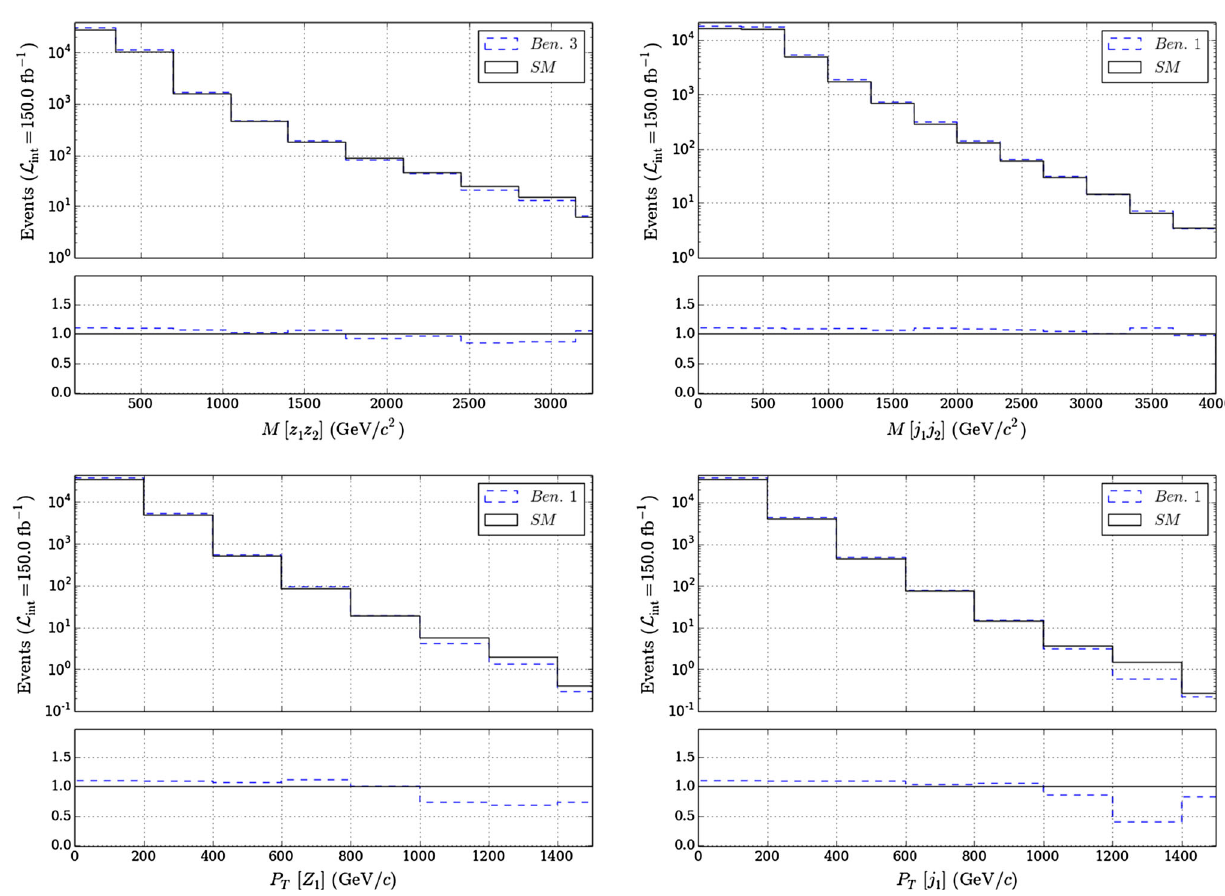
Fig. 11 Effect of the B1 scenario in the background process. The effect is in principle very small; however, it is important to remark that the number of background events is about one order of magnitude larger, per bin, than that for the